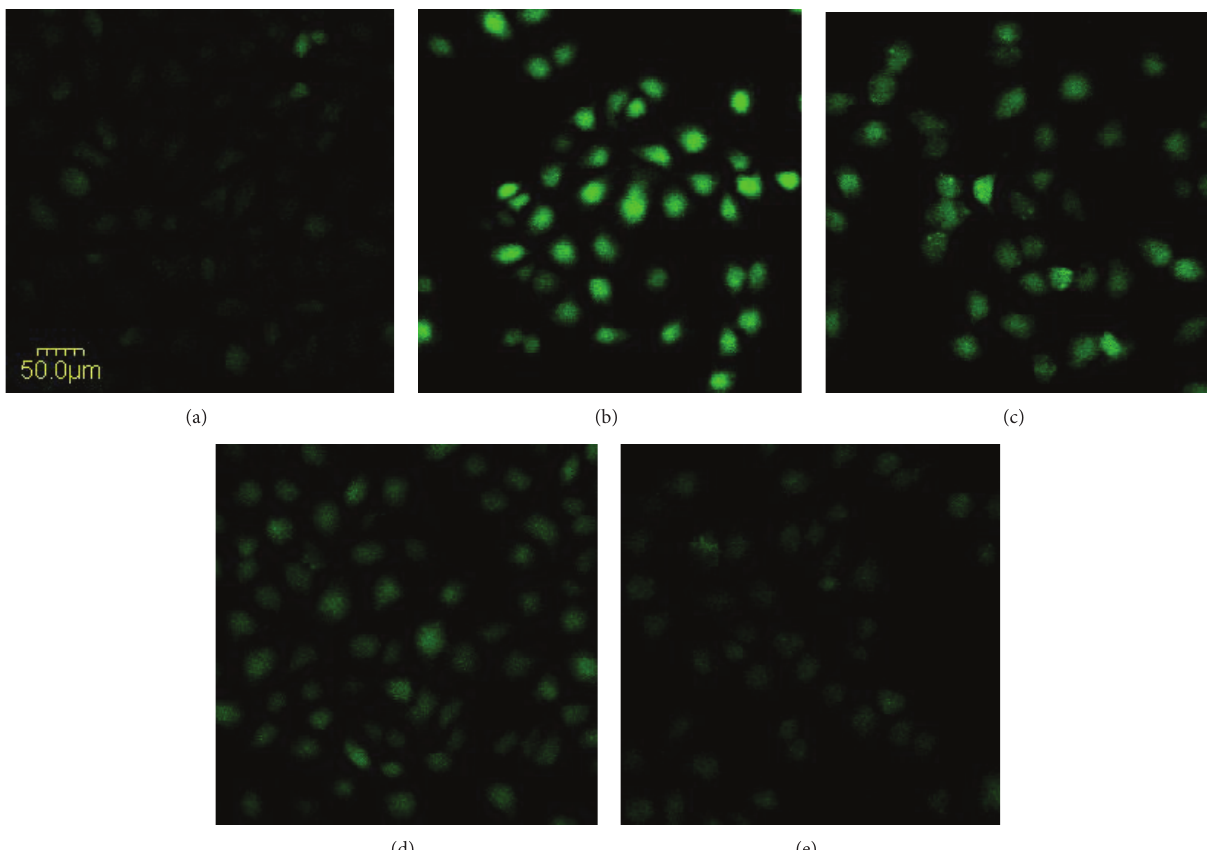
Figure 3: The effects of berberine on ROS in HUVECs exposed to palmitate. HUVECs were cultured in RPMI-1640 containing 0.5mmol/L palmitate and treated with 1.25, 2.5, and 5 𝜇 mol/L berberine for 12 h. HUVECs were labeled with DCFH-DA for 20min and ROS generation was analyzed by fluorescence detection with Confocal microscopy at 200x. (a) HUVECs were cultured in RPMI 1640 without palmitate; (b) HUVECs were stimulated by 0.5 mmol/L palmitate; ((c), (d) and (e)) HUVECs were stimulated by 0.5 mmol/L palmitate and treated with 1.25, 2.5, and 5 𝜇 mol/L berberine,